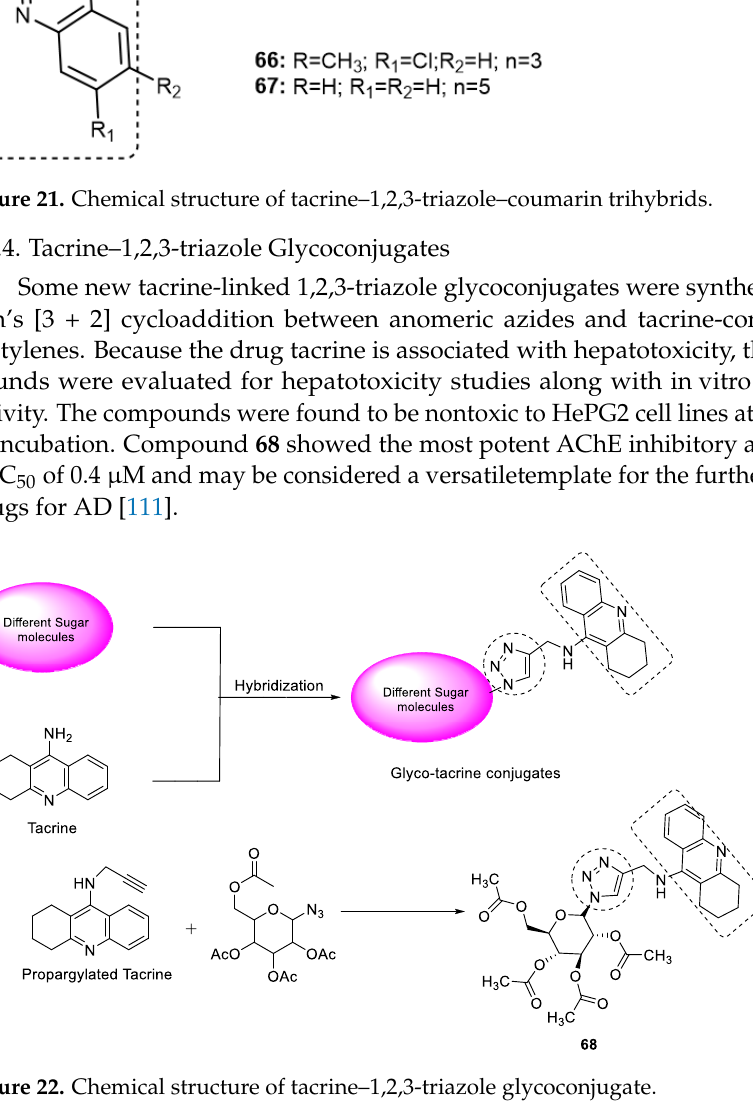
Figure 22. Chemical structure of tacrine – 1,2,3-triazole glycoconjugate.